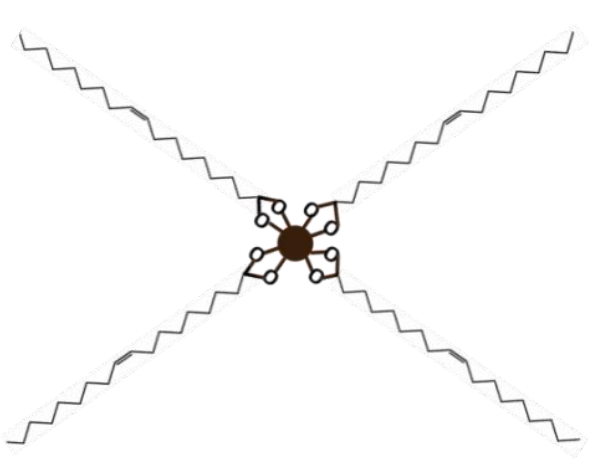
Figure 3. Representation of the oleic acid-particle structure.